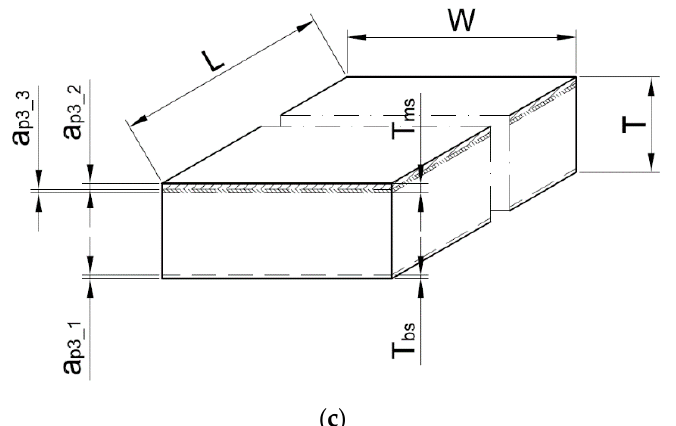
Figure 3. Three experimental research strategies for face milling of aluminium alloy plates: strategy